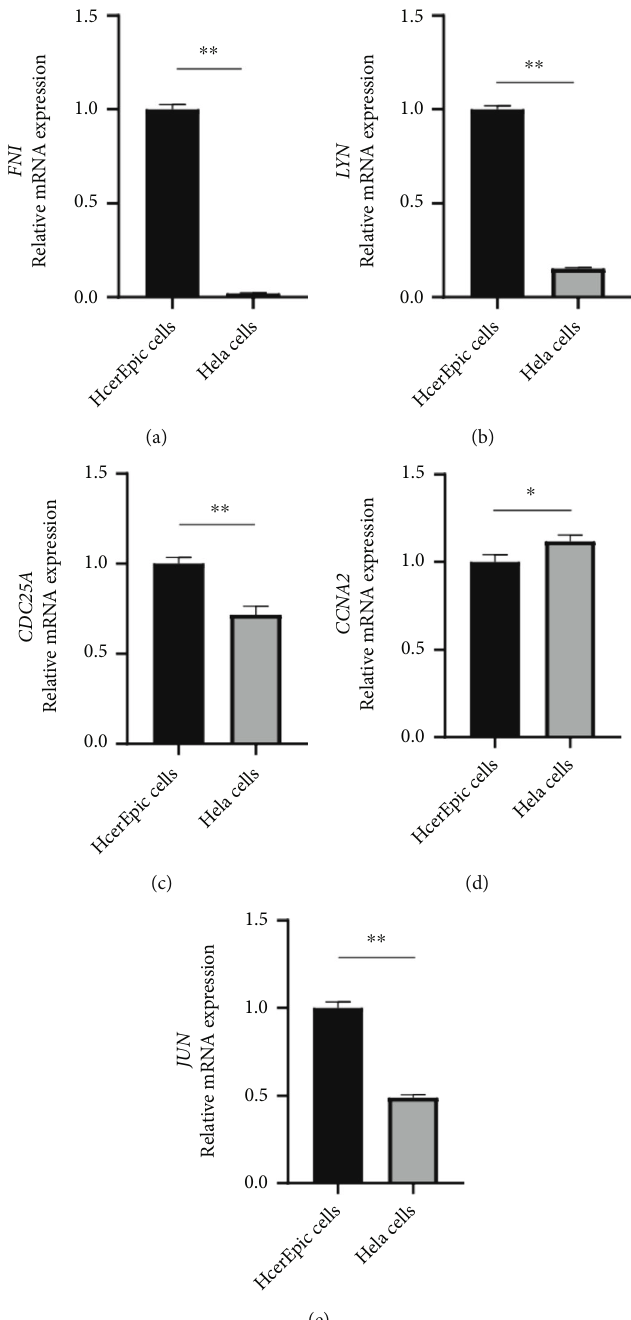
Figure 12: Expression of ARGs prognostic signature in CC (** P < 0.01, * P <